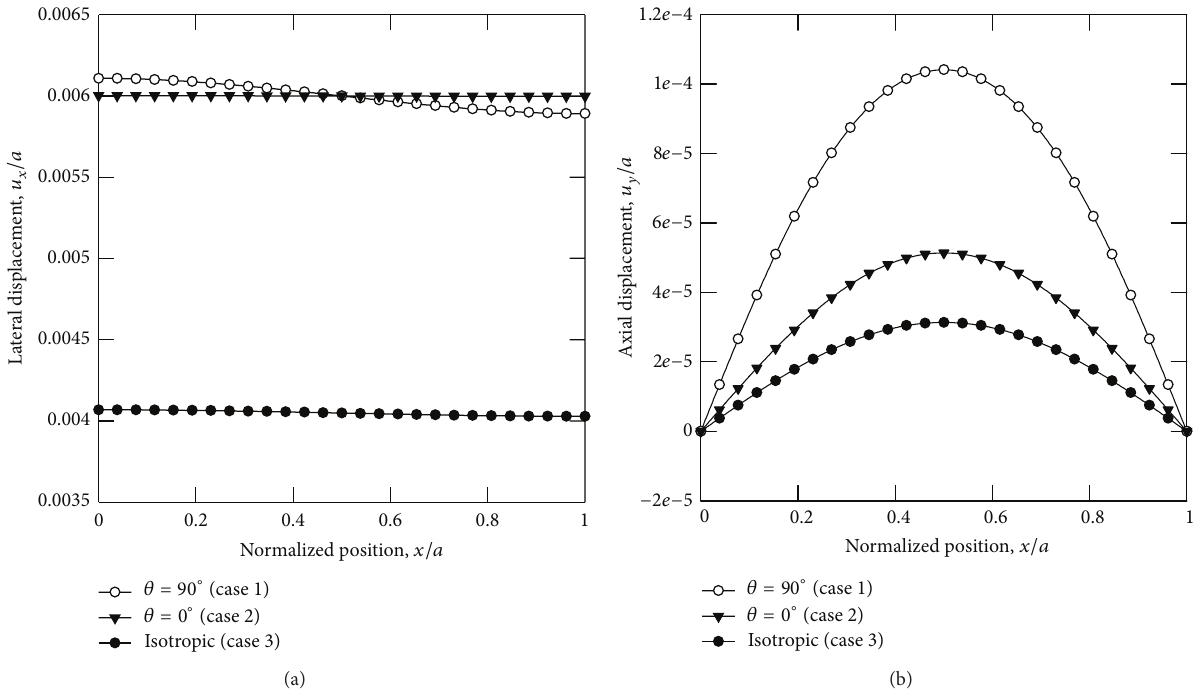
Figure 5: Effect of fiber orientation and material isotropy on the normalized displacement components at the section 𝑦/𝑏 = 0.5 of the panel: (a) lateral displacement; (b) axial